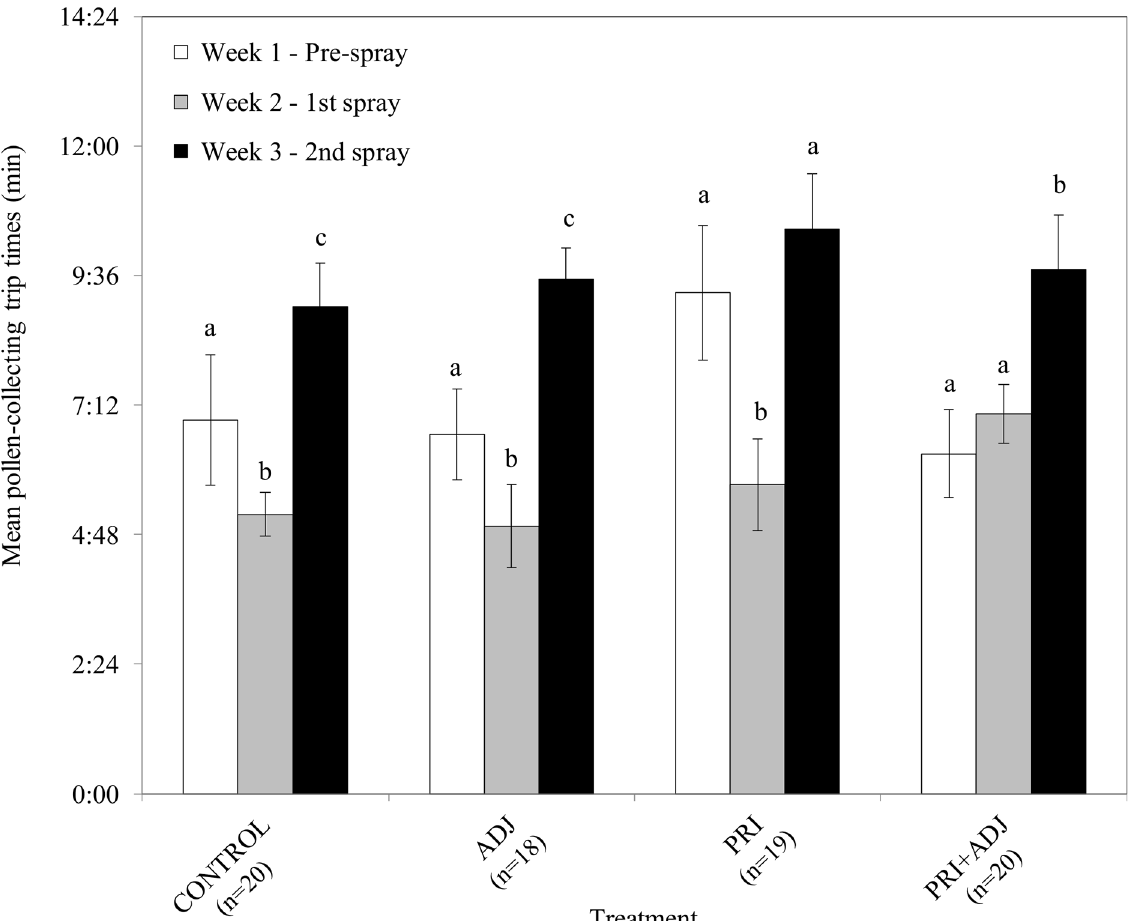
Fig 3. Mean pollen-collecting trip times by Megachile rotundata females before and after treatment applications. Means within each treatment with different letters are significantly different ( P < 0.05).